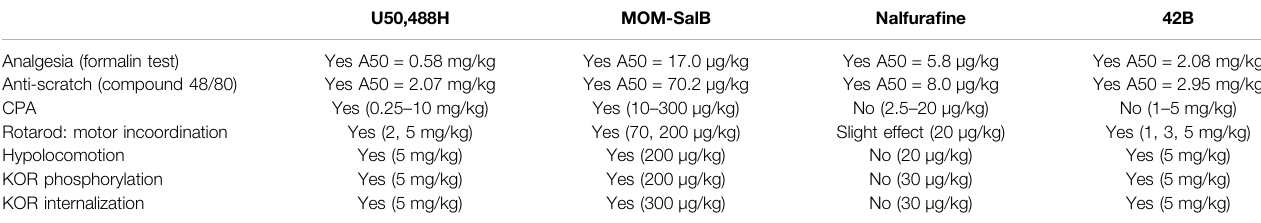
TABLE 1 | Summary of effects of the four kappa opioid receptor (KOR) agonists on behaviors and KOR phosphorylation and